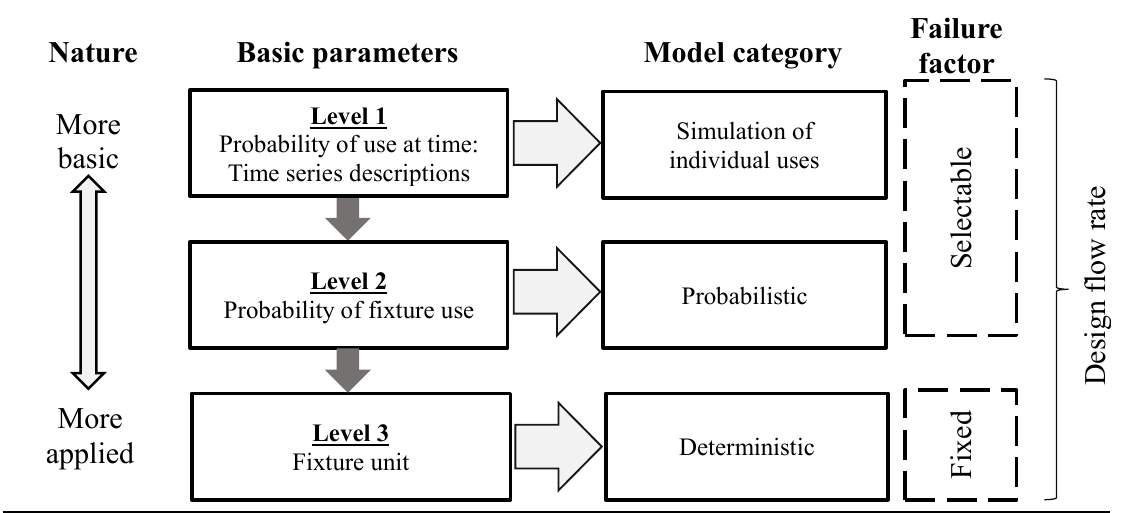
Figure 1. Demand models for water systems in buildings.